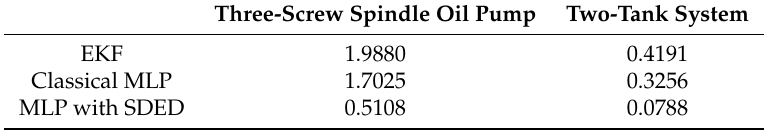
Table 1. Mean Uncertainty Interval (MUI) obtained with the application of the Extended Kalman Filter (EKF), classical Multi-Layer Perceptron (MLP) and MLP with Sequential D-optimum Experimental Design